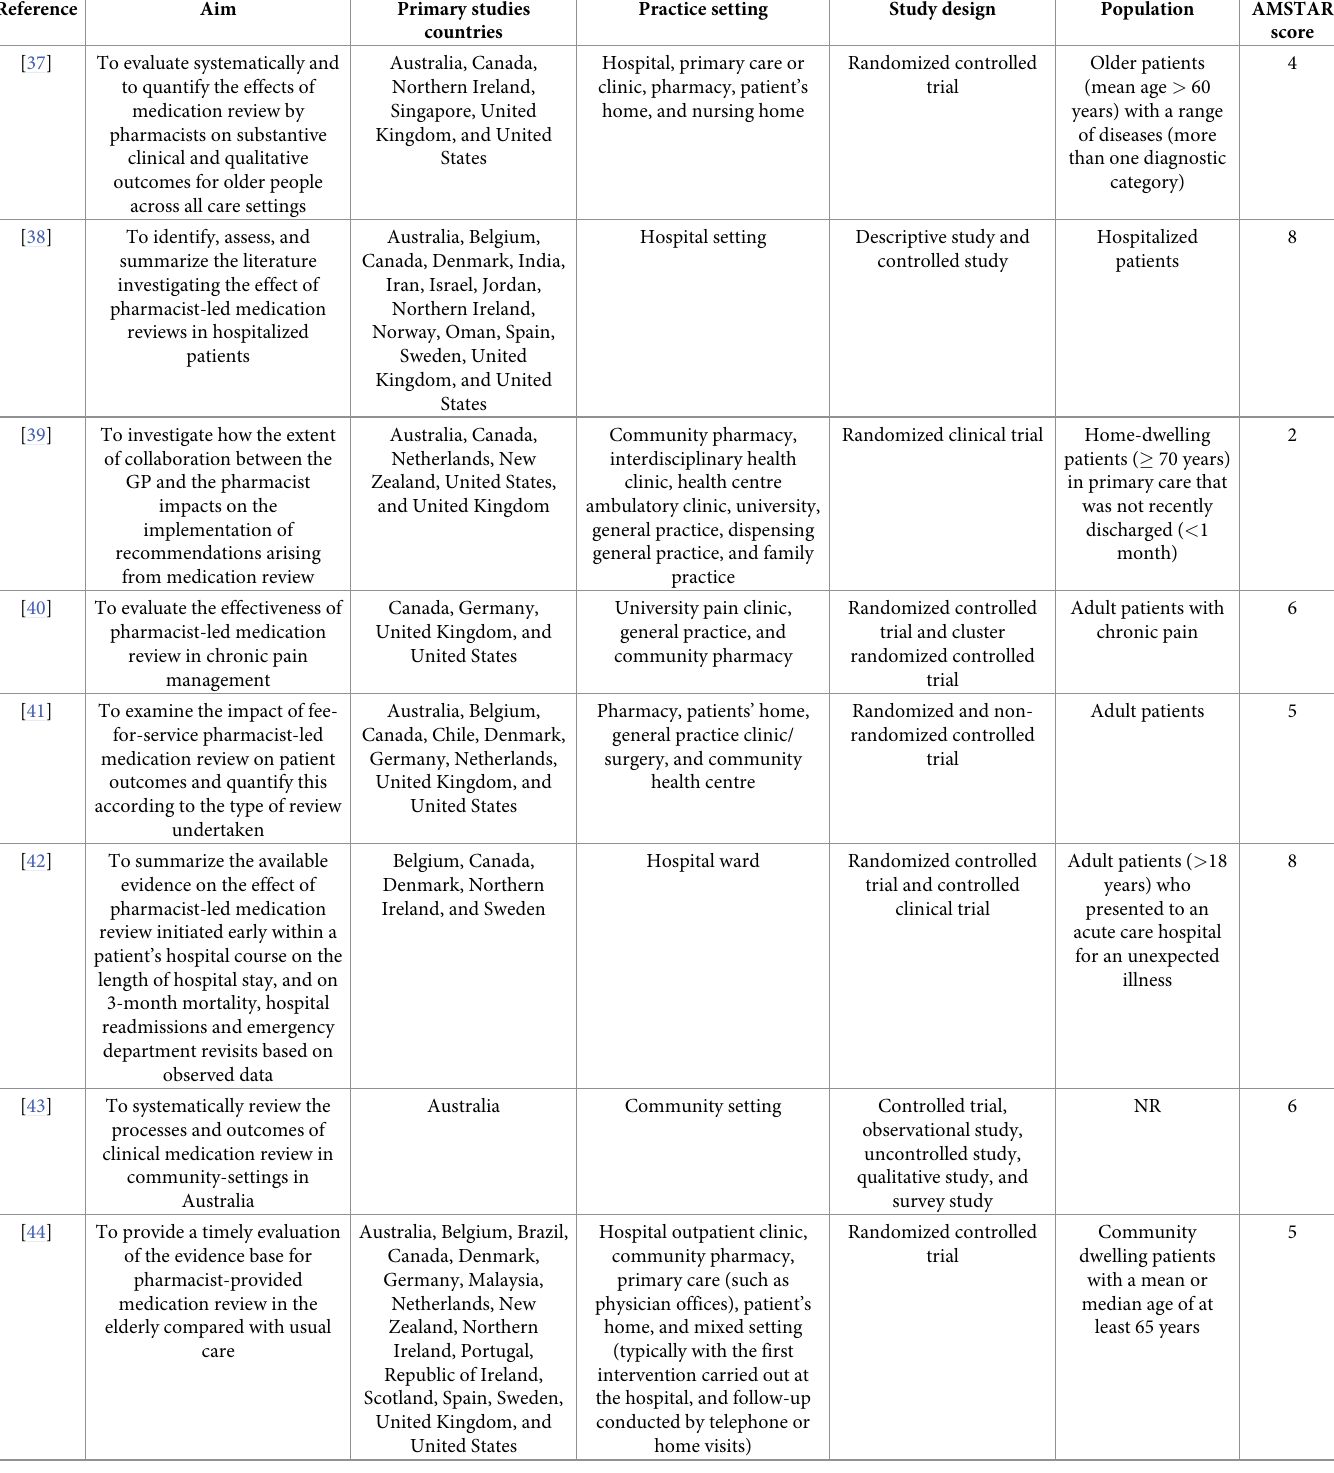
Table 1. Description of the systematic reviews’ aim; primary studies’ countries, practice setting, study design and population; and AMSTAR score for quality assess- ment of systematic reviews followed or not by meta-analyzes.